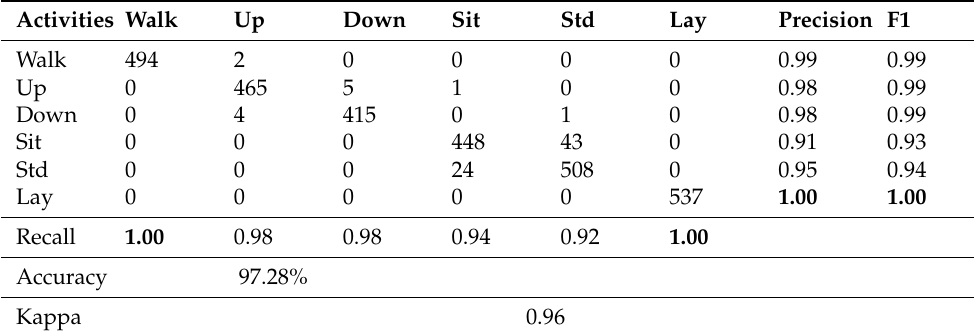
Table 7. Classification of the confusion matrix on the UCI-HAR using the proposed model, CNN- BiLSTM, as a feature extractor and SVM as a